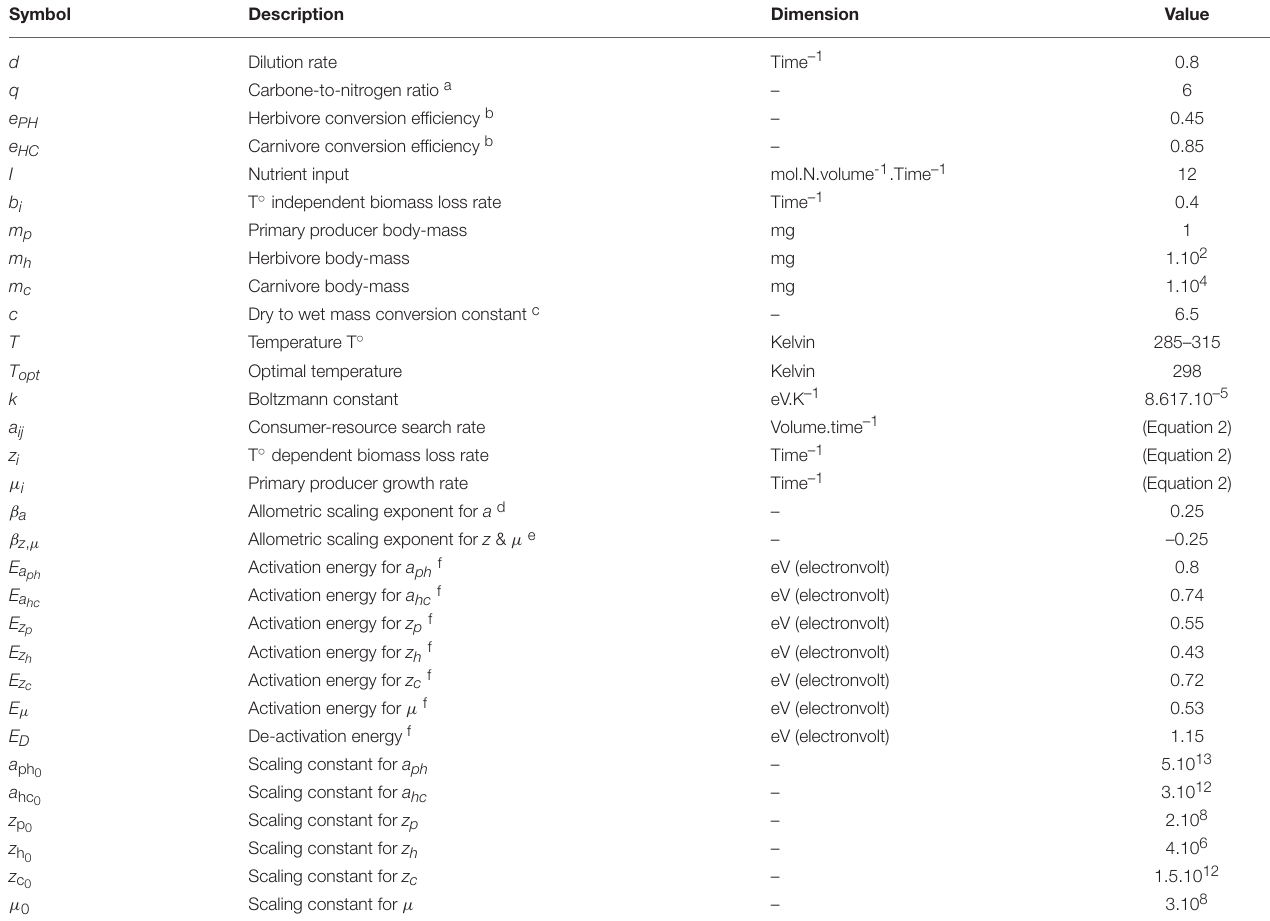
TABLE 1 | Parameters descriptions and